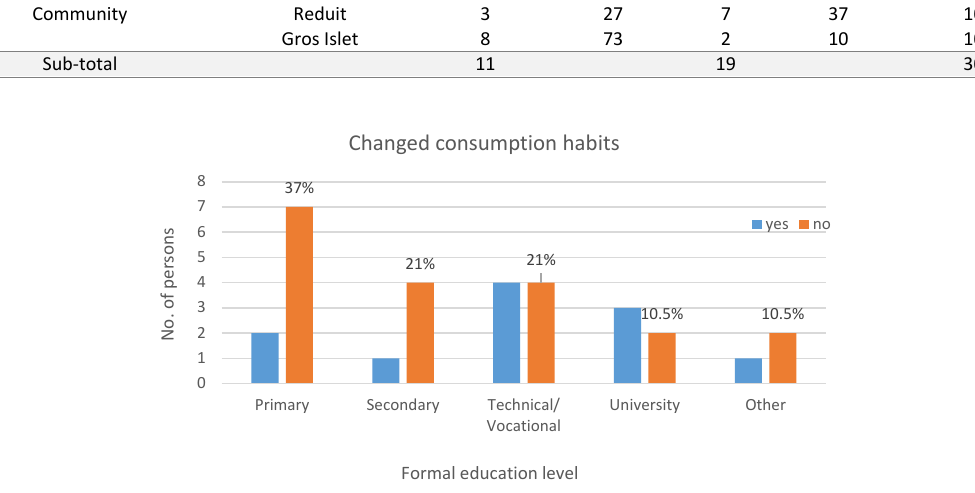
Fig. 4: Changed consumption habits by education